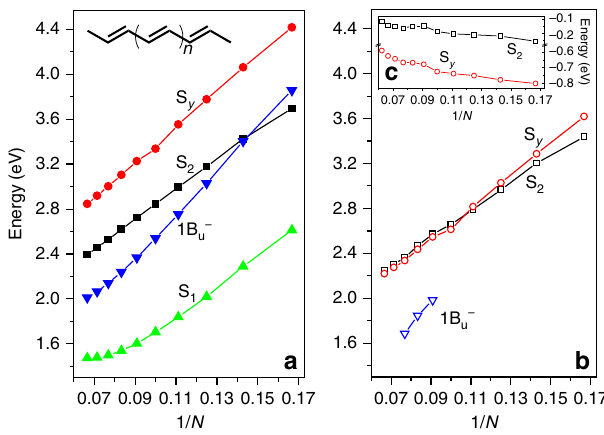
Fig. 6 Simulated two-dimensional (2D) electronic spectrum of Rps. acidophila at the population time T = 200 fs. The diagonal peaks are symbolized by the corresponding state; the cross-peaks indicate that energy is transferred from the state represented by the fi rst symbol to the acceptor state represented by the second